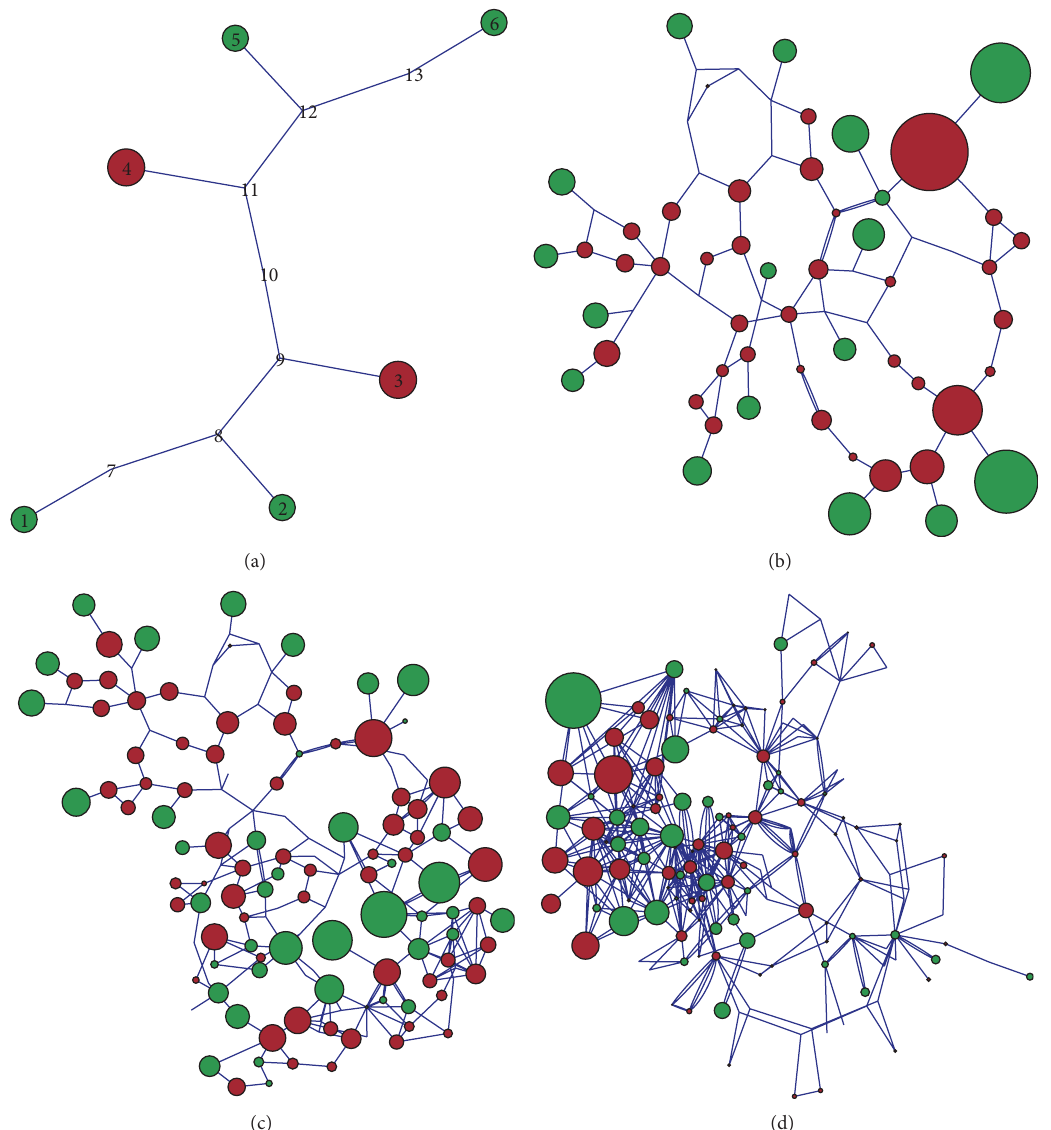
Figure 3: Test power grid multigraphs (a) G 4 , (b) G 16 , (c) G 48 , and (d) G 50 . Nodes are scaled as a function of the MW injected (generators, green dots) or withdrawn (loads, red dots). Since transmission nodes inject zero active power, they are scaled to zero but can be recognized as junctions or direction changes of lines, for example, nodes 11 and 7, respectively, in